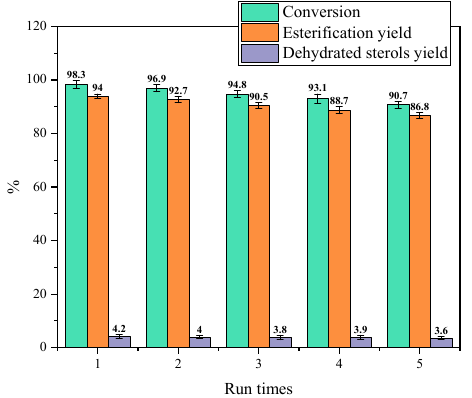
Figure 6. Experiments of catalyst recovery.